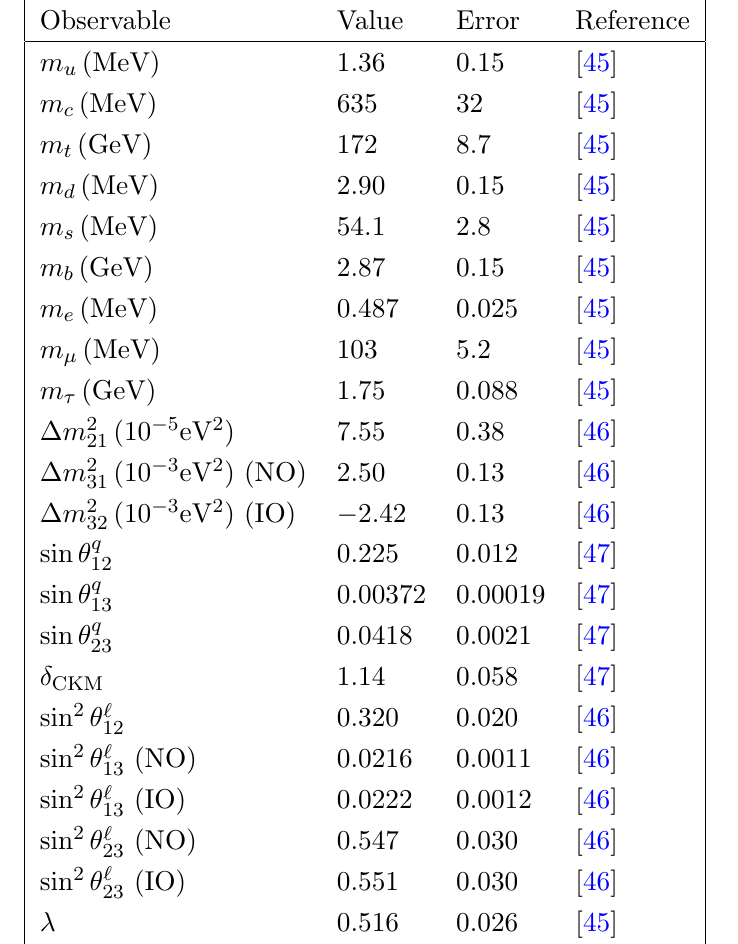
Table 1 . Data for the SM observables at M Z and their corresponding errors used in the (cid:12)ts. The abbreviations NO and IO stand for normal neutrino mass ordering and inverted neutrino mass ordering,